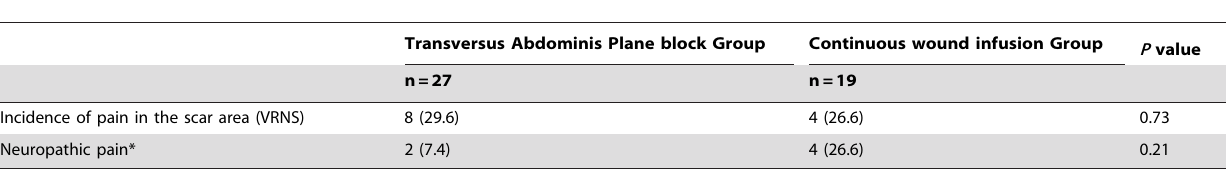
Table 3. Main results obtained from the a follow-up postal standardized questionnaire, presented as numbers